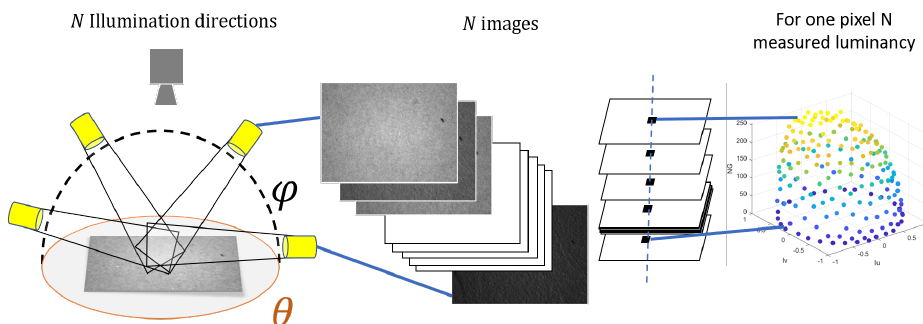
Figure 1. Diagram of an RTI